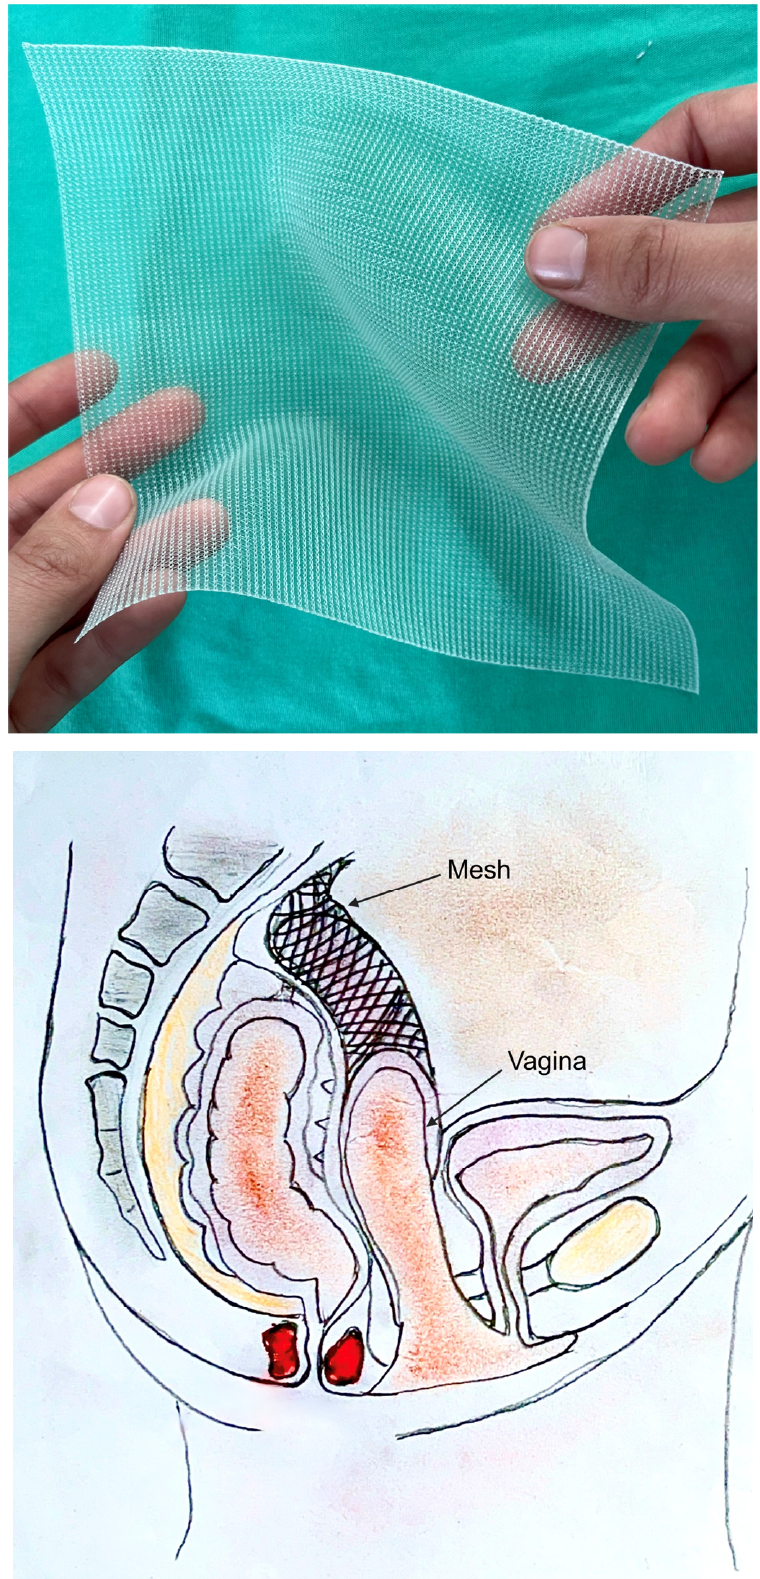
Figure 2. ( a ) Image of polypropylene synthetic mesh used to treat pelvic organ prolapse; ( b ) Image demonstrating the placement of polypropylene mesh in abdominal sacrocolpoplexy—surgical method to treat vaginal vault prolapse.